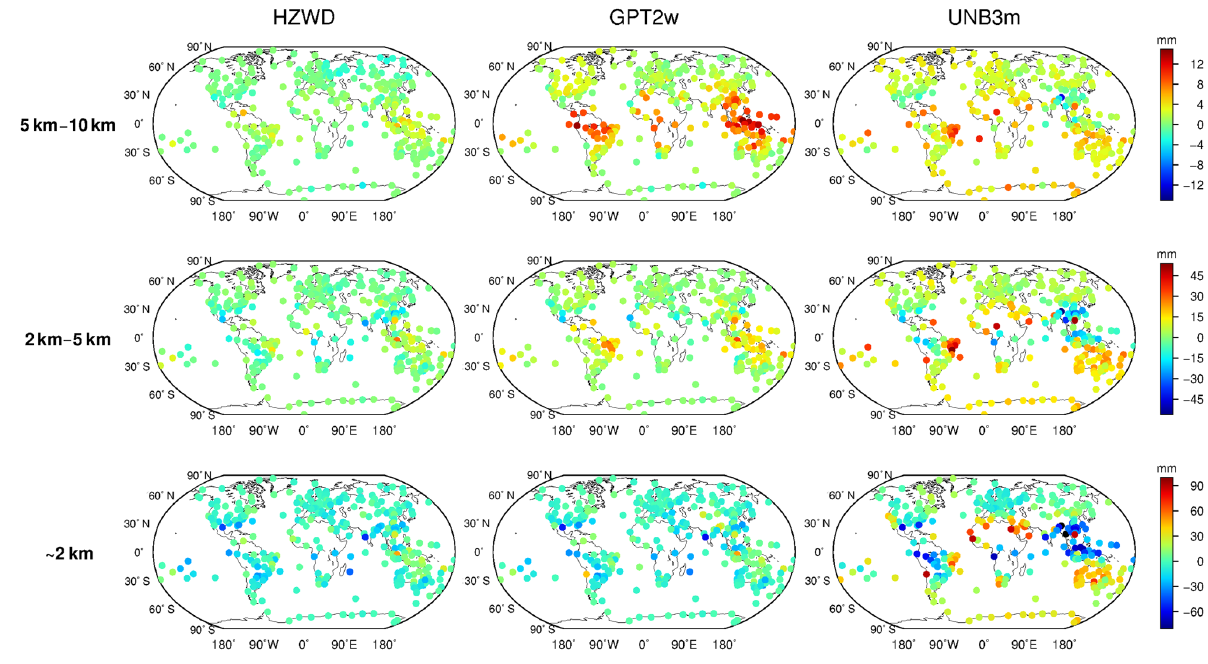
Figure 12. Global distributions of bias for the three models (HZWD, GPT2w, and UNB3m) compared to 2015 radiosonde data.